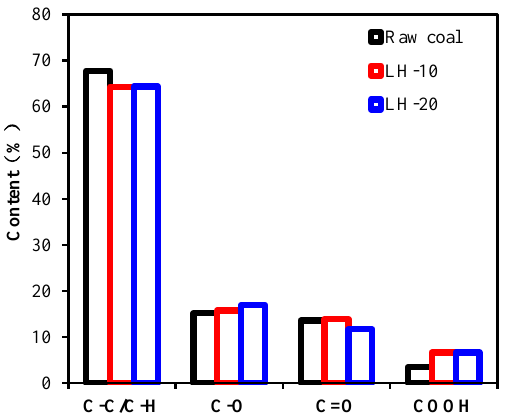
Figure 9. Functional groups of coal surface before and after heating oxidation at 200 °C from peak fitting of the XPS C1s peak.